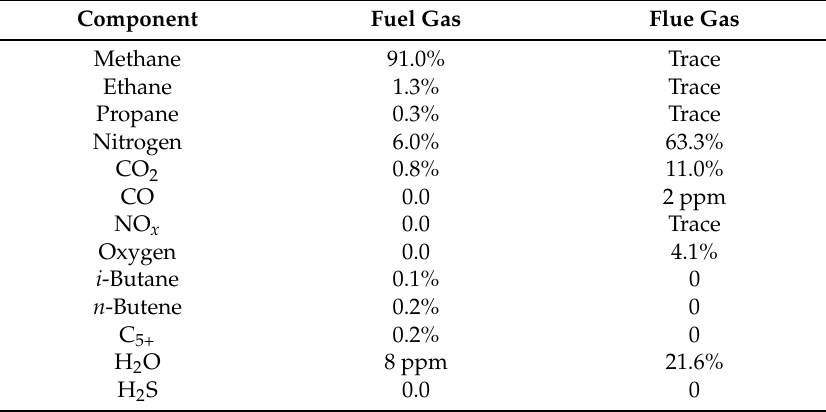
Table 3. Composition of fuel gas and flue